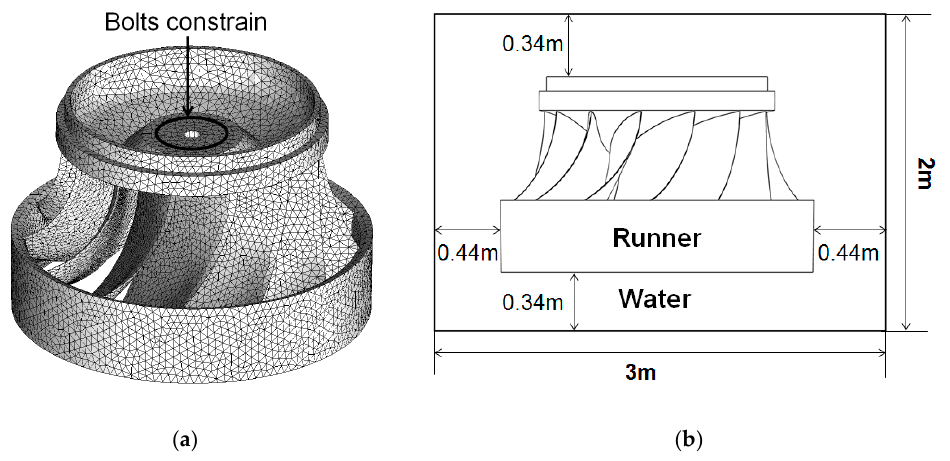
Figure 11. ( a ) Geometry and boundary conditions of the runner in air; ( b ) geometry and dimensions of the surrounding cylindrical water domain.